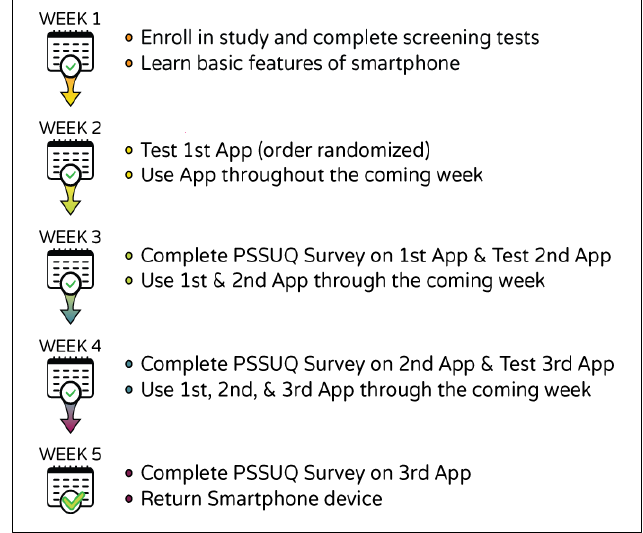
Figure 1. The step-wise process in which usability testing of the iMHere modules occurred over a period of five